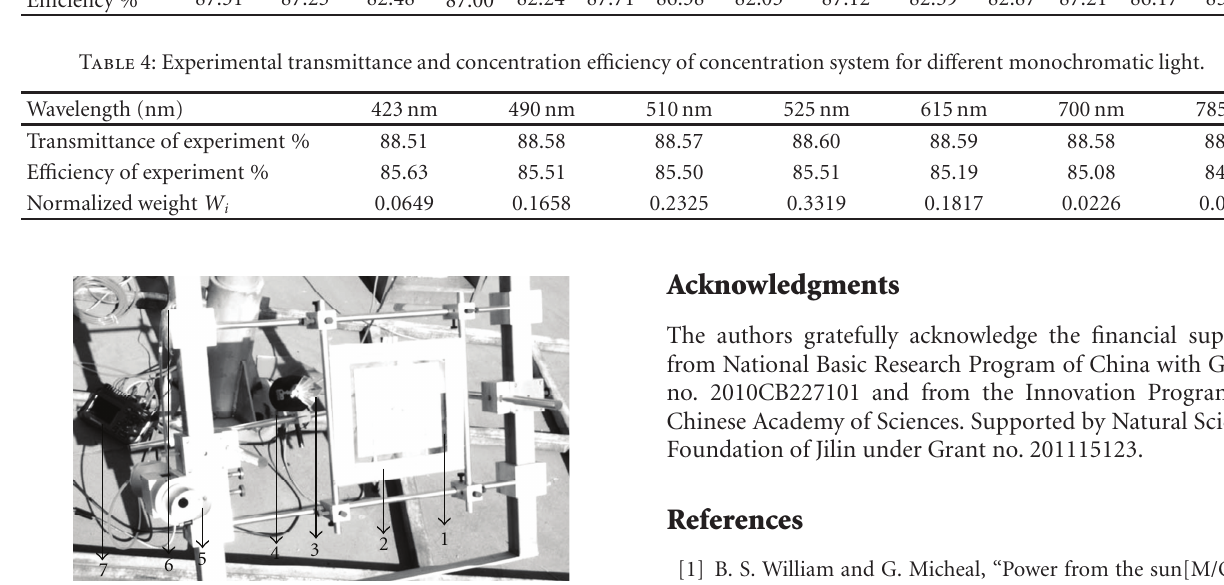
Figure 13: Physical map of concentration test system. 1. Fresnel concentrator, 2. stop, 3. light funnel, 4. powermeter, 5. pyrheliome- ter, 6. fiber spectrometer, and 7.